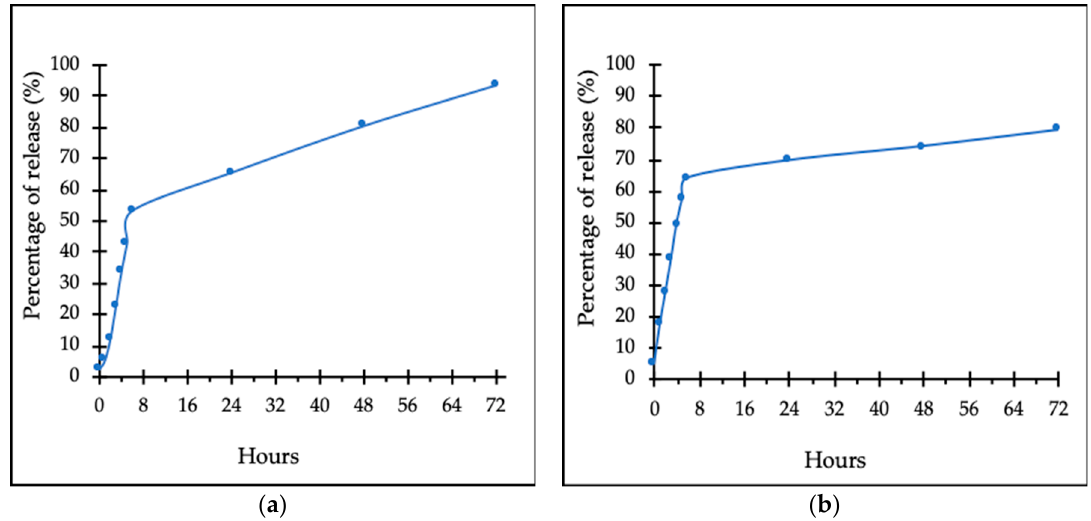
Figure 5. In vitro drug release profiles of ( a ) 93.56% pure Citral (5 mg / mL) ( b ) 79.25% of Citral-loaded self nano-emulsifying drug deliverysystem (CIT-SNEDDS) release after 72 h at 37.0 ± 0.3 ◦ C.